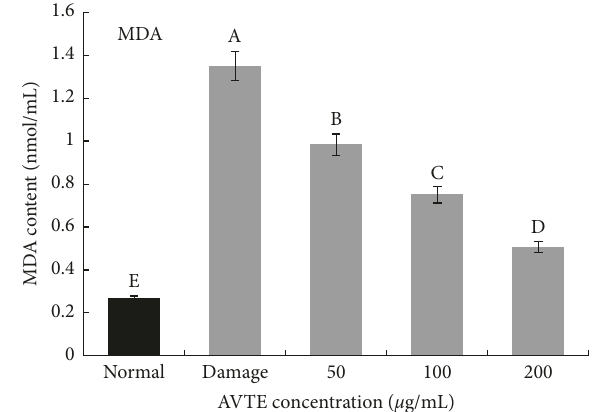
Figure 5: Effect of AVTE on the levels of MDA in 293T cells exposed to H 2 O 2 . a–e Mean values with different letters in the same bar graph are significantly different ( P < 0 . 05) according to Dun- can’s multiple range test.